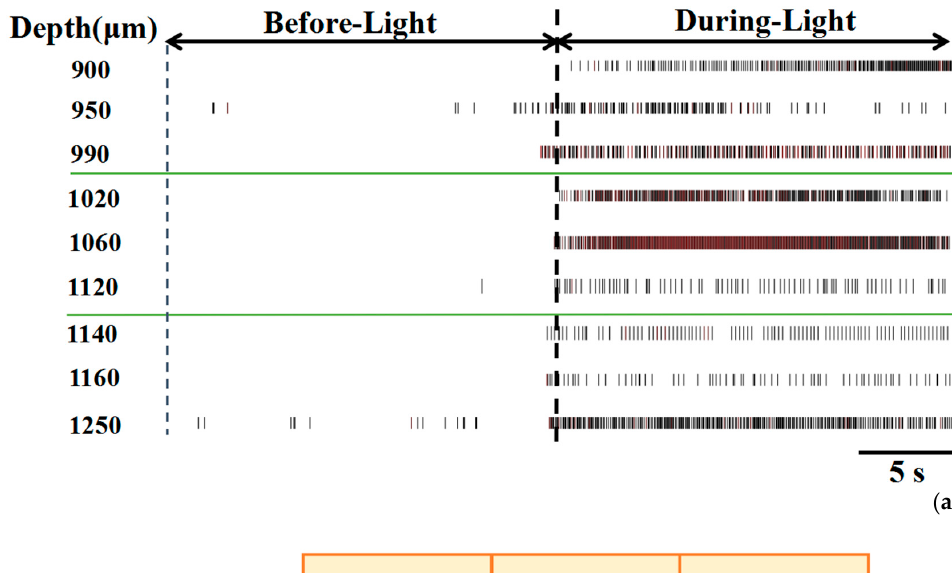
Figure 2. ( a ) The real-time recordings of electrophysiological signals before and during light illumination in viral transfection areas; ( b ) the average spike firing rate of neurons before and during optical stimulation; ( c ) the mean LFP power (0–30 Hz) of neurons before and during optical stimulation. Error bars indicate standard deviation of 3 channels.